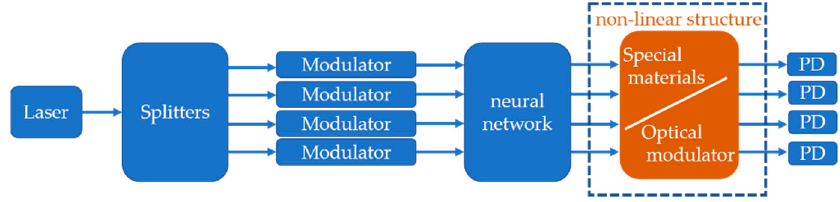
Figure 7. Ideal PAIC system implementation diagram. The dotted line is nonlinear structure.